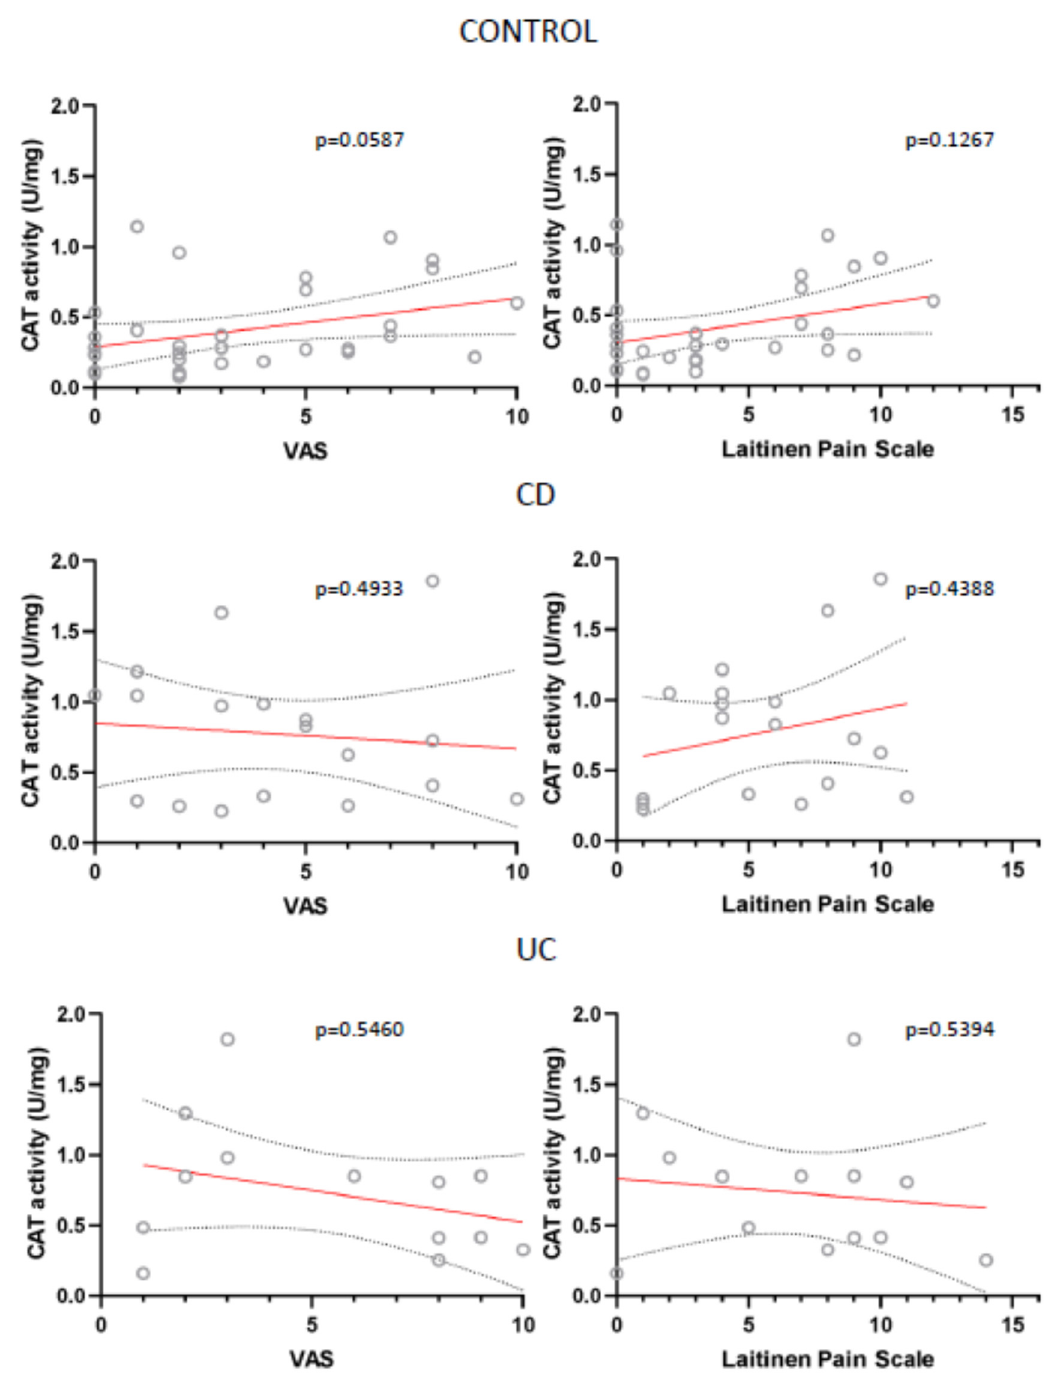
Figure 9. Correlation between the mean values of visual analog scale (VAS) for quantification of disease-related pain, the values of modified Laitinen Pain Scale and CAT activity (U/mg sample) in controls, CD and UC patients.